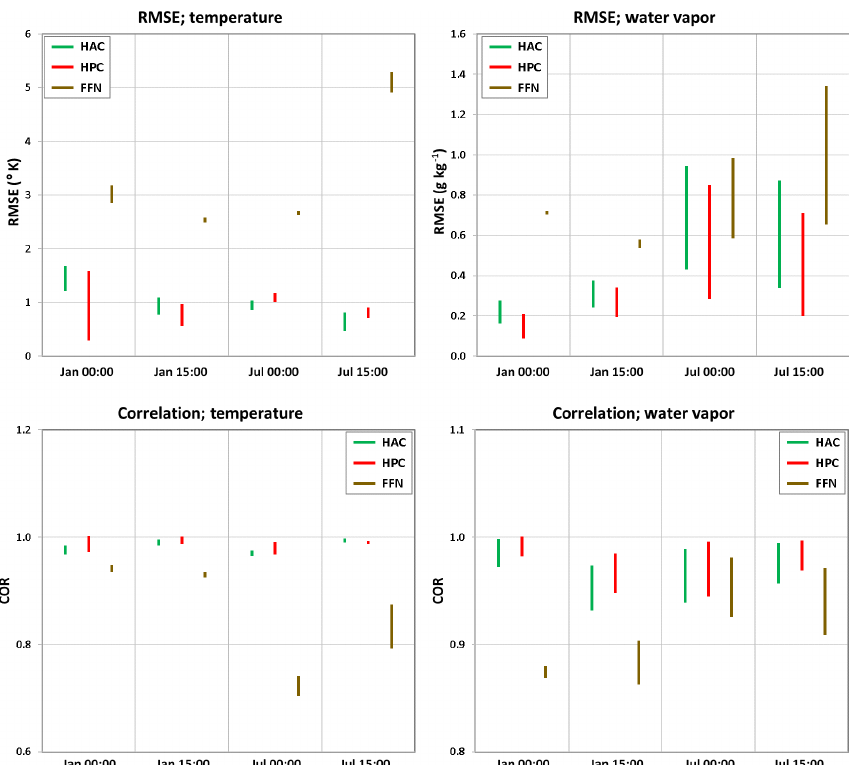
Figure 3. RMSE and correlations for time series of temperature and water vapor vertical profiles within the PBL predicted by the three DNNs compared with the observations. The vertical lines show the range of RMSEs and correlations when considering the lowest and highest PBL heights (shown by the dashed horizontal lines in Fig.